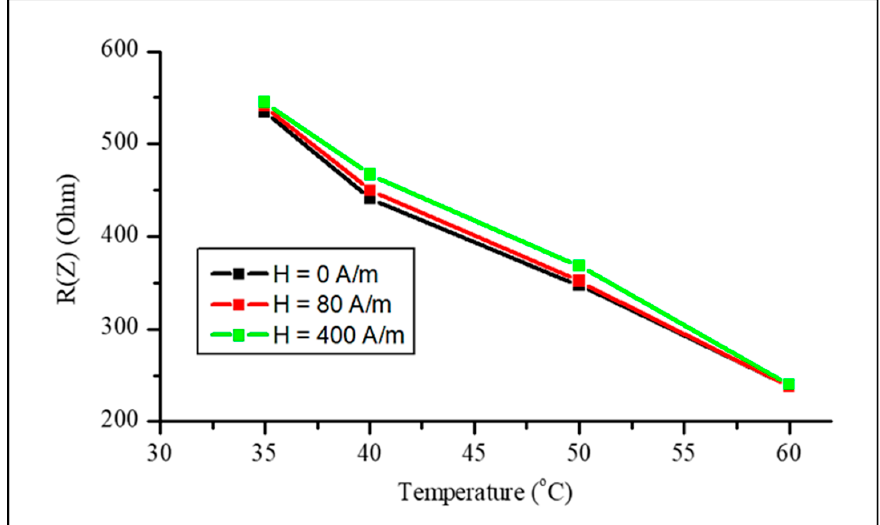
Figure 20. Real part of impedance (at 300 MHz) vs. temperature for as-prepared amorphous Fe 3.9 Co 64.82 B 10.2 Si 12 Cr 9 Mo 0.08 microwires for fixed external magnetic fields.